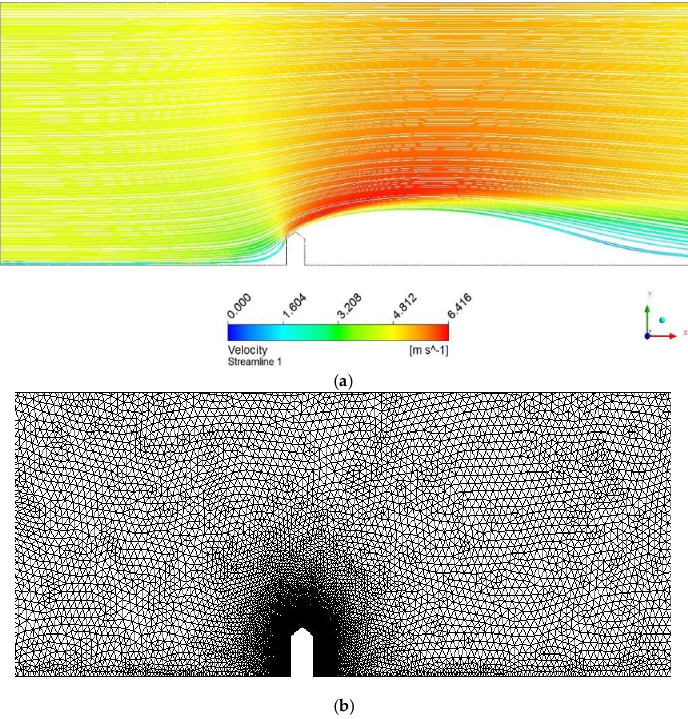
Figure 8. ( a ) Velocity streamline for gable rooftop; and ( b ) 2 D mesh for the building model. The boundary layer separates at the windward roof edge of the building and the flow forms a separation bubble on the roof (below the streamline above the roof). As a consequence, the velocity vector of the flow above the separation bubble makes an angle with the horizontal edge of the roof (Figure 8a). This angle is referred to as the skewed angle. The skewed angle is largest at the windward roof edge and decreases downwind [33]. From the simulation, the wind velocity along the centre line of the roof at Y = 100, 150, 200 and 250 mm was found to be 5.36, 5.8, 5.95 and 5.97 m/s respectively, it shows that the wind speed achieved high velocity at this points due to the accelerating effect on the building and comparing with the inlet wind speed, 4.5 m/s, the wind velocity at the above mention height of the CAWT increases by 19%, 29%, 32%, and 33% with a wind speed augmented factor f = 1.19, 1.28, 1.32, and 1.33, respectively. 5. Methods 5.1. Prototype Fabrication A prototype was built and integrated on a mock-up building model with a gable-shaped roof with dimensions (length, width, and height) of 1450 mm × 740 mm × 1364 mm. The feasibility of integrating the CAWT onto a building with gable-shaped rooftop is investigated through an experimental study using a mock-up rooftop. The performance of the CAWT was compared with the